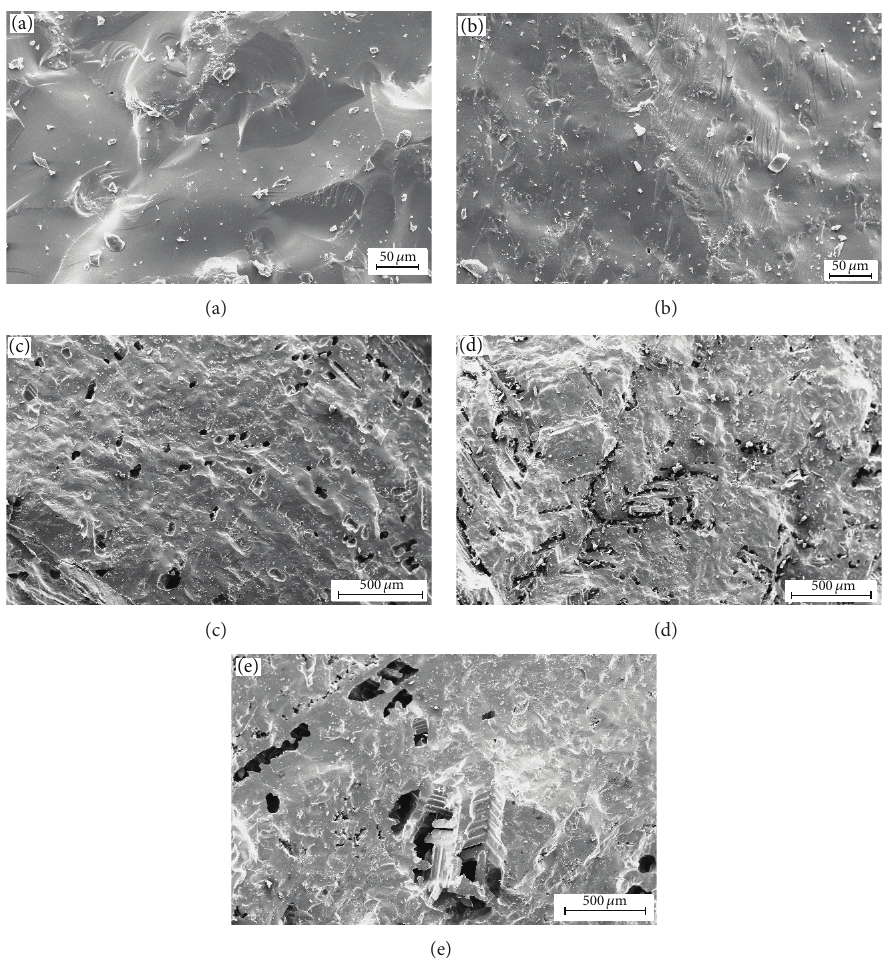
Figure 6: SEM images of samples synthesized for different times: (a) 30 min, (b) 60min, (c) 90min, (d) 120 min, and (e) 150 min.